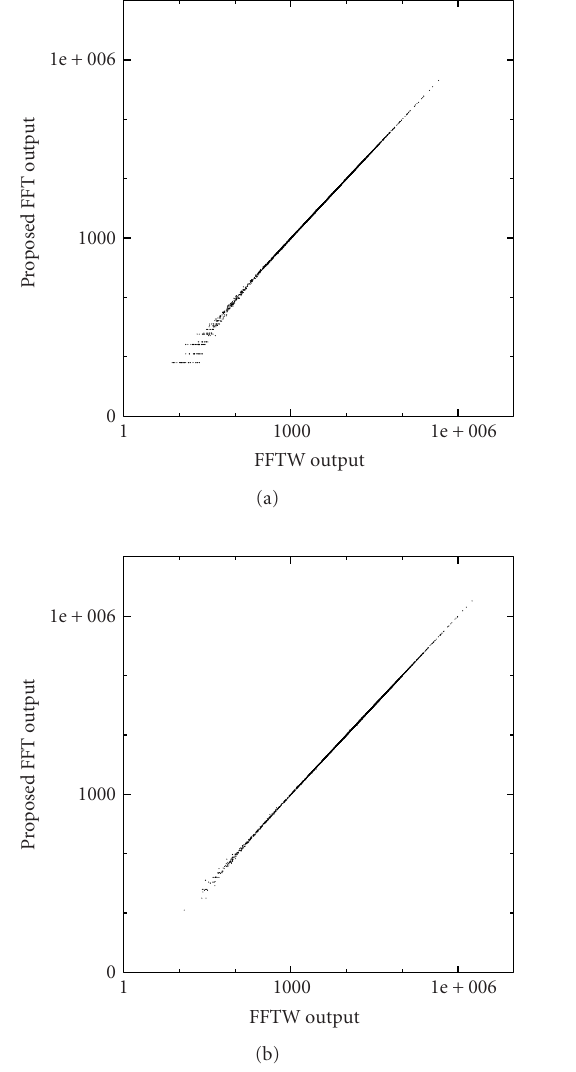
Figure 7: Scatter plot of proposed FFT output against FFTW out- put for the TIMIT signal x (a) and 4 x (b), scales are logarithmic.